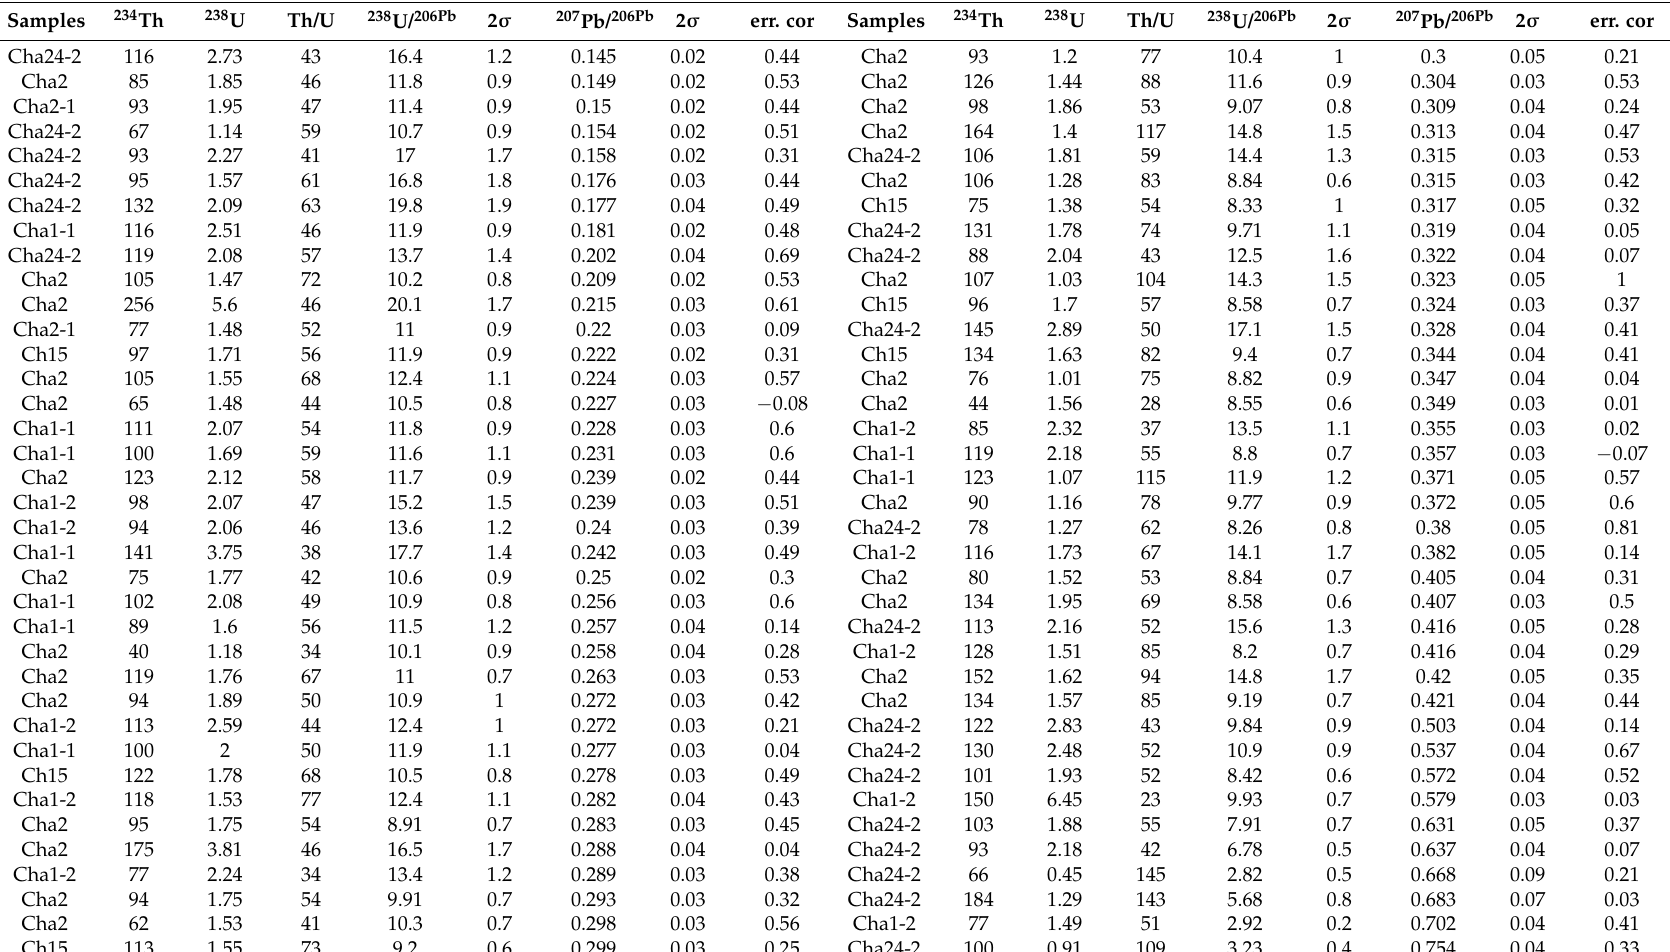
Table 8. U-Pb-Th isotope compositions and isotope ratios for the bright, high-REE apatites, Chadormalu deposit (abundances in ppm).